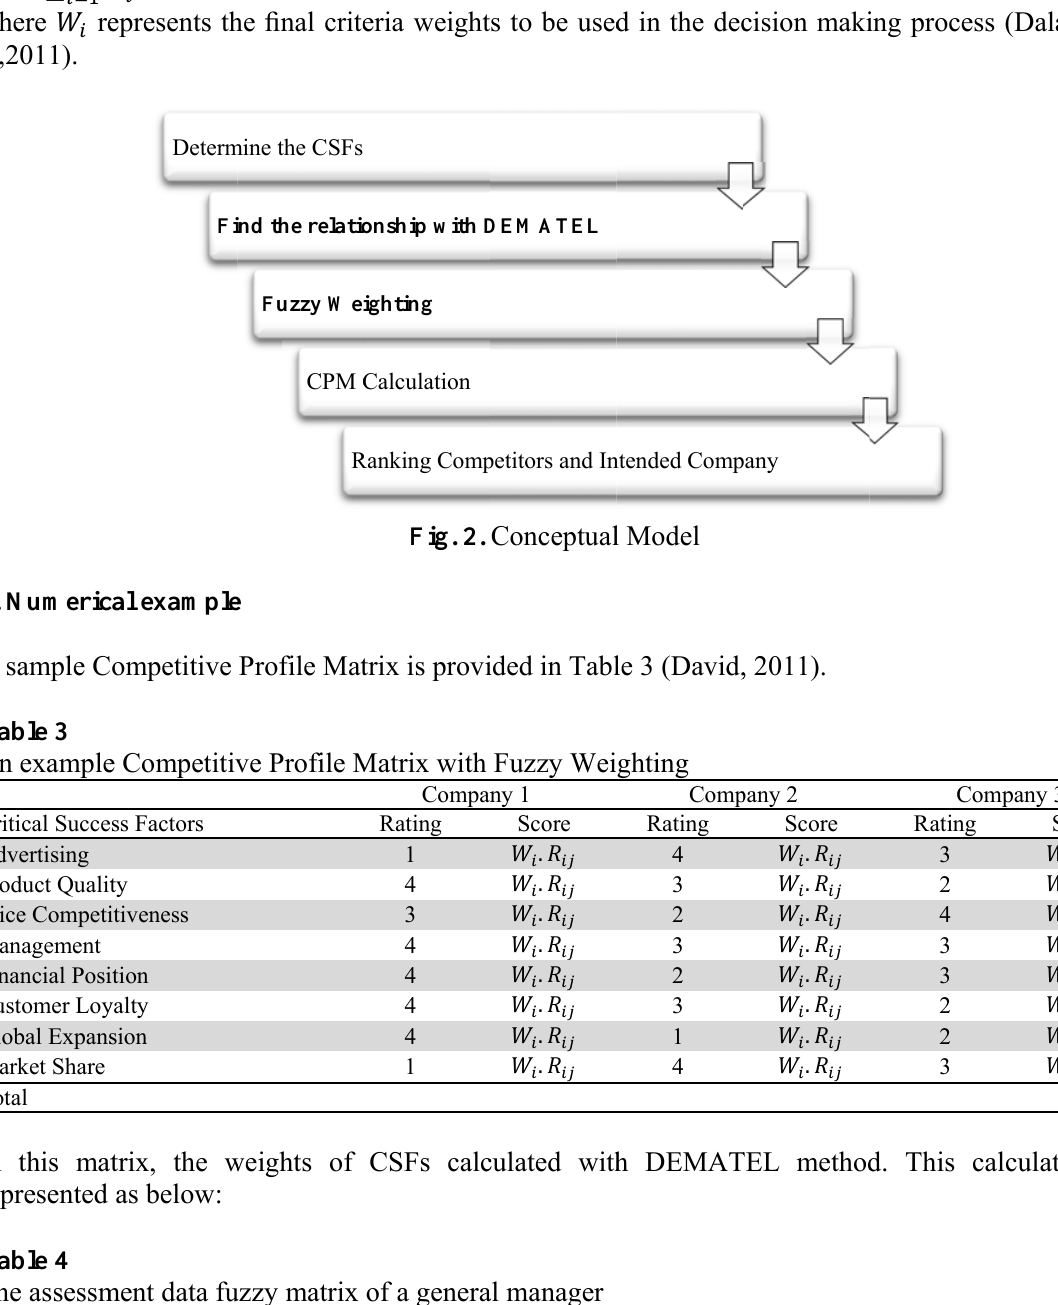
The assessm Advertising Product Quality